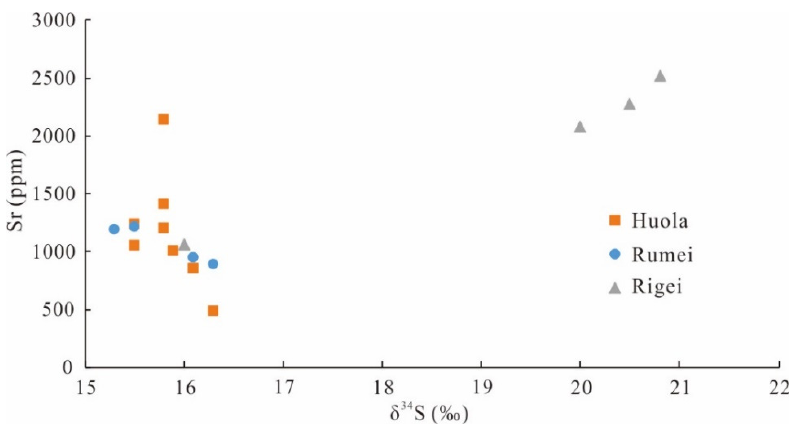
Figure 8. The Sr contents and S isotope compositions of gypsums from the Qamdo Basin. The linear correlation between the Mg and Sr contents of the samples from Huola indicates that as was discussed above, these gypsum samples formed during an increasingly more saline environment. Except for three samples with abnormally high Sr contents, the Sr contents and S isotope values are roughly negatively correlated (Figure 8), which suggests that the gypsum precipitation became gradually more depleted in 34 S as the evaporation progressed. As a result, the variations in the δ 34 S values (15.3‰ to 16.3‰) of the samples that were not affected by BSR were likely caused by S isotope fractionation during